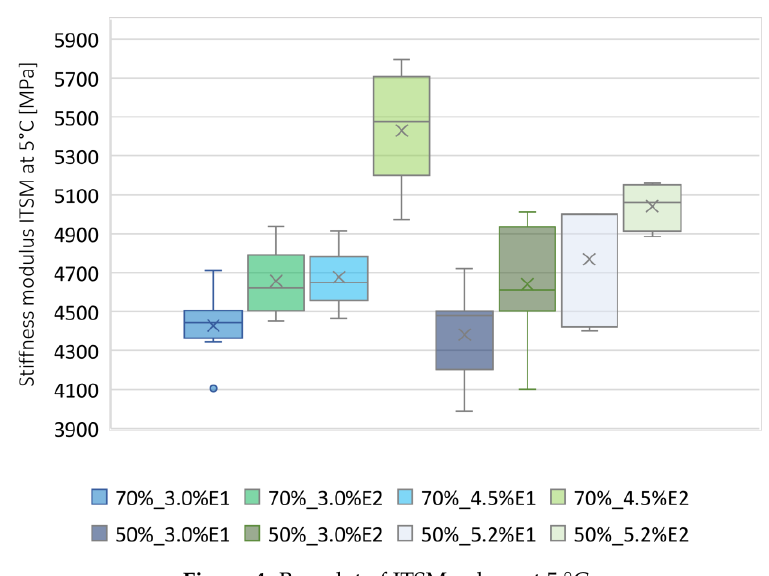
Figure 4. Box plot of ITSM values at 5 °C.